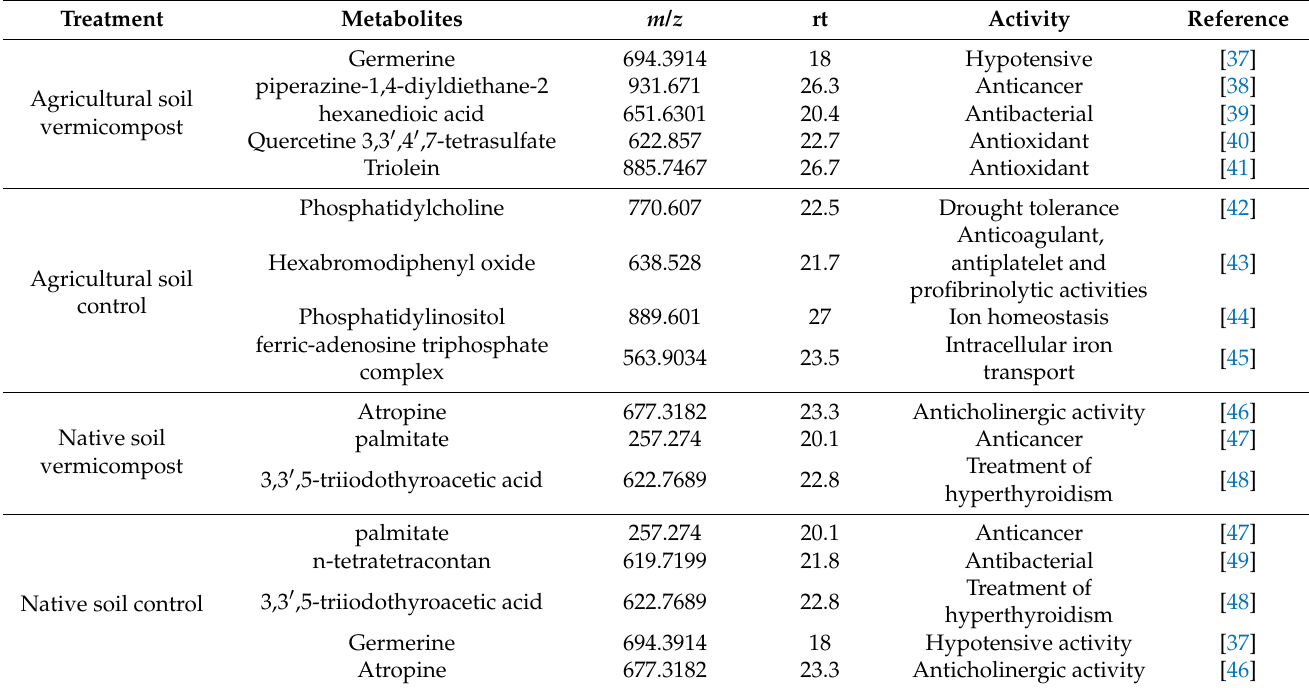
Table 4. Identification of putative metabolites from Moringa oleifera with biological potential.